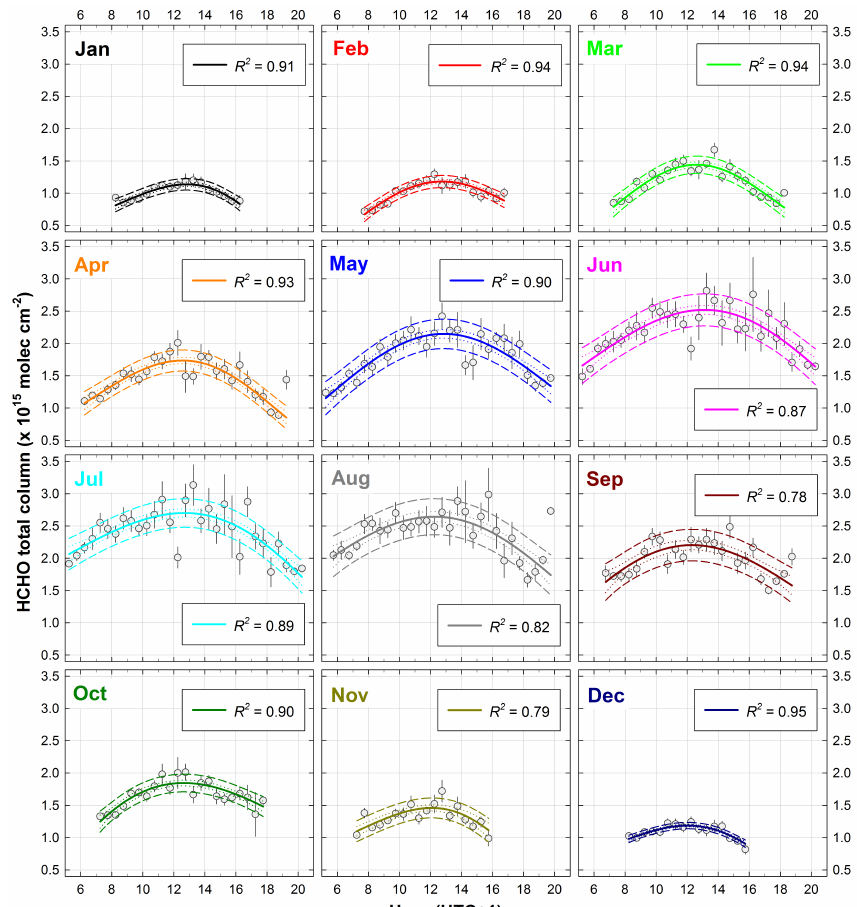
Figure 1. Intra-day variation of the HCHO abundance, represented by the 0.5h time step average (as grey circles) and corresponding standard error of the mean (as error bars) of the HCHO total columns (in moleccm − 2 ) derived from all individual observations made by the Bruker instrument between January 1995 and June 2015 at the ISSJ. It is expressed according to the hour of the day (UTC + 1) and for each month of the year. No smoothing has been applied here. The solid color curves are the fits of the monthly running averages of the individual observations by the parametric model (Eq. 1), associated with the 95% confidence and prediction intervals delimited by the dotted and dashed color curves, respectively. The running average used here corresponds to a 0.5h time step and a 1.5h wide integration length. The coefficient of determination ( R 2 ) of the model fit is provided for each month in the legend. All the monthly fits by the parametric model are displayed on the same graph in Fig. 3a, Sect.